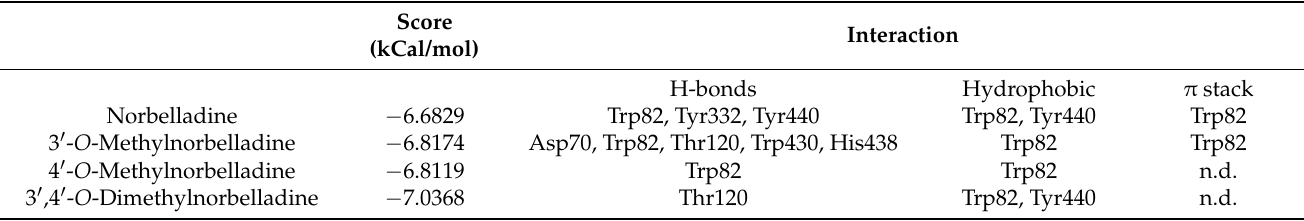
Figure 5. Anti-Alzheimer’s disease properties. ( a ) Prolyl oligopeptidase inhibition by norcraugsodine, 3 ′ -O-methylnorcraugsodine, and 3 ′ -O-methylnorbelladine. ( b ) Acetylcholinesterase inhibition of 3 ′ ,4 ′ -O-methylnorbelladine using acetylthiocholine as the substrate. ( c ) Butyrylcholinesterase (BuChE) inhibition of norbelladine and derivatives using butyrylthiocholine (BuTCh) as the substrate. ( d ) Butyrylcholinesterase inhibition of norbelladine and derivatives using acetylthiocholine (ATCh) as the substrate. Galanthamine (10 μ M) was used as the positive control for the AchE assays, while rivastigamine (2 m M) was used for the BuChE assays (100% inhibition not shown on the graph). Table 2. Predictions of norbelladine derivatives’ interactions with